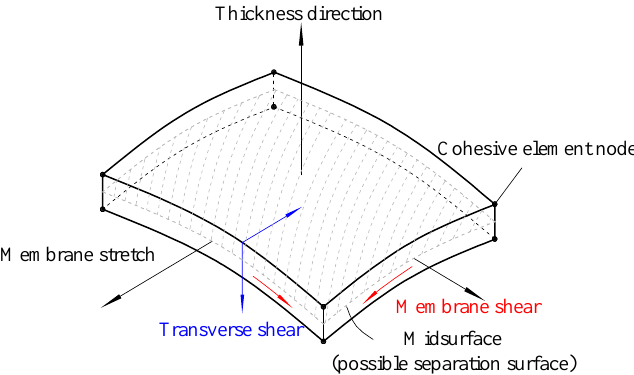
Figure 3. Spatial representation of CH3D8 (eight-node three-dimensional) cohesive element.